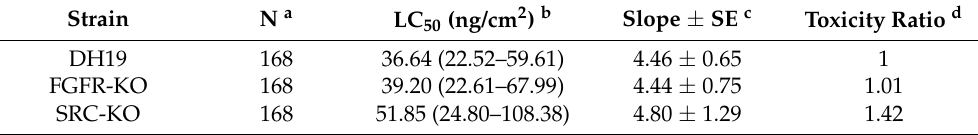
Table 1. Susceptibility of DH19, FGFR-KO, and SRC-KO strains to the Vip3Aa toxin.